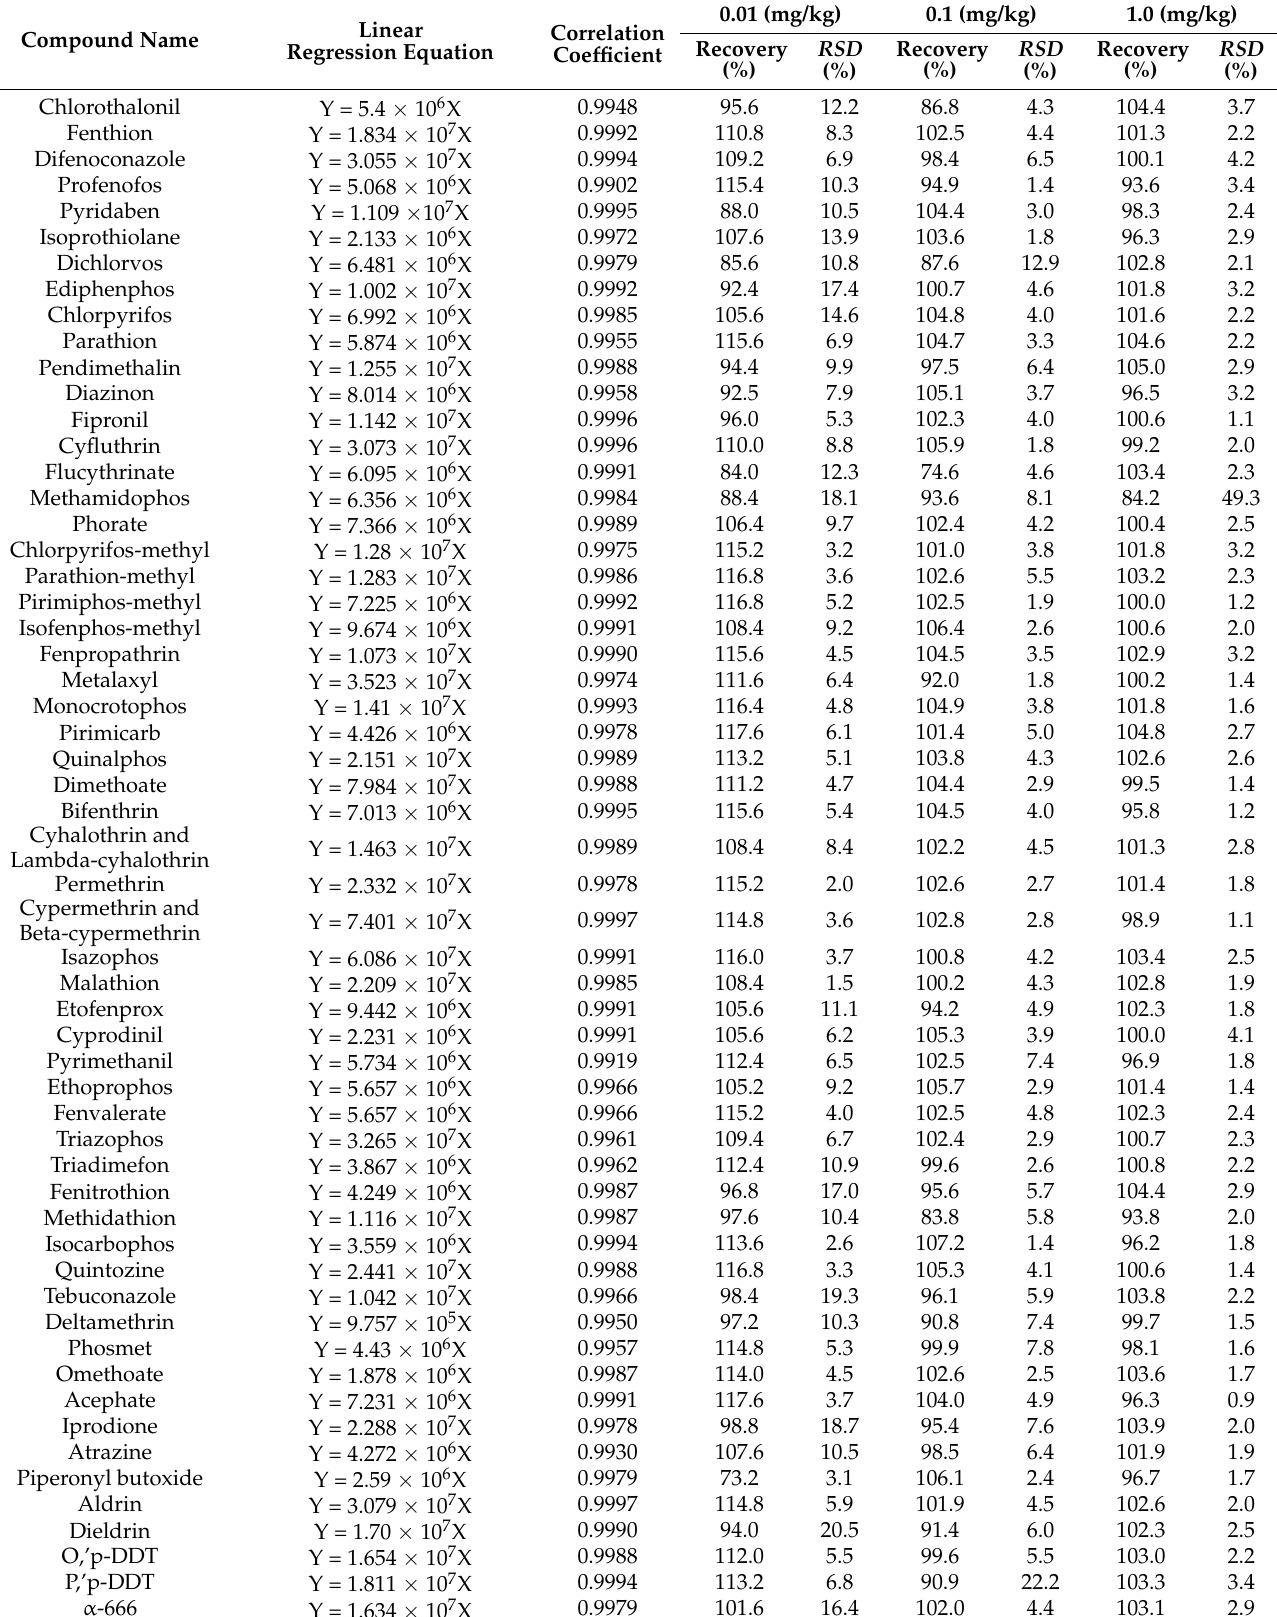
Table A4. The linear regression equation, recovery and precision for 60 pesticides analyzed by